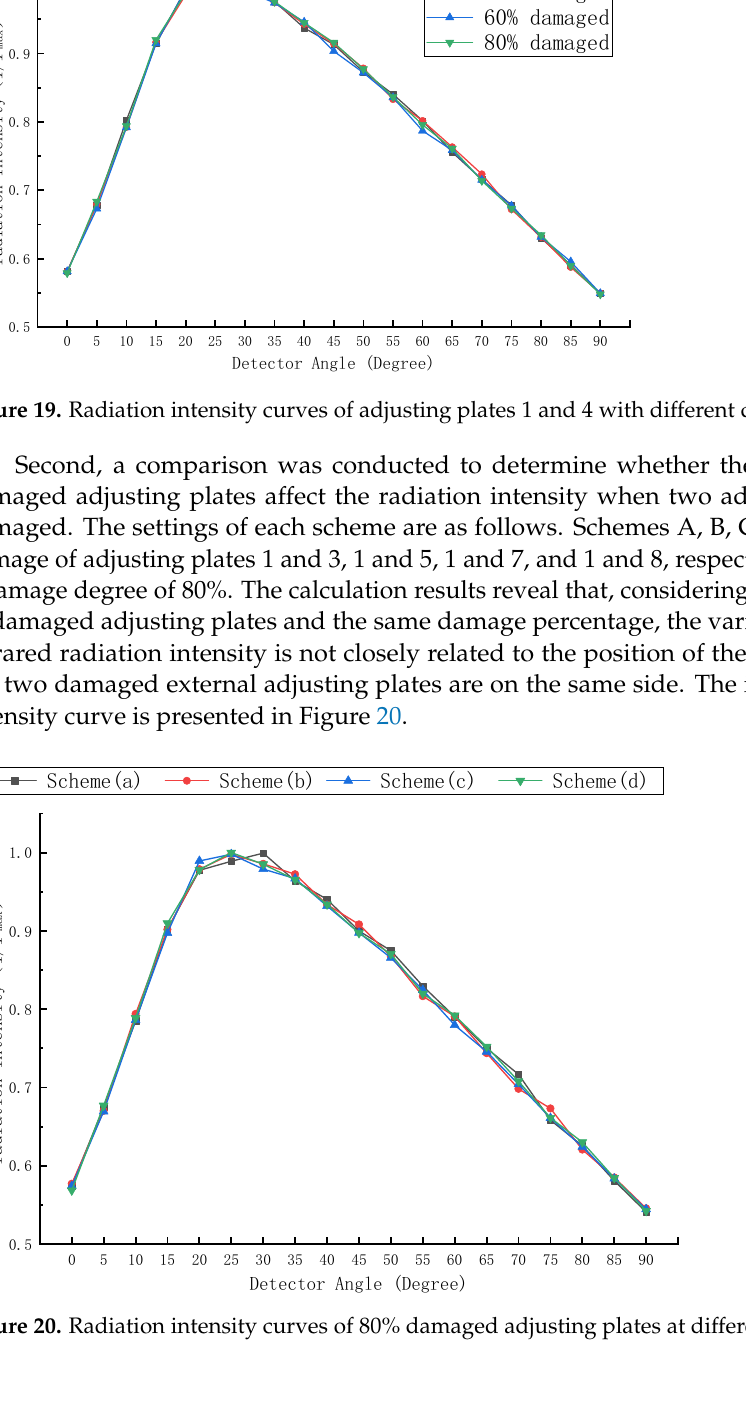
Figure 21. Comparison of radiation intensity with different numbers of damaged regulating plates. Based on previous research, it was learned that the damage of a single adjusting plate has little effect on the overall radiation intensity. Thus, the damage degree of all the ad- justing plates was set at 80%. As the number of damaged adjusting plates increases, the overall radiation intensifies and the integral radiation intensity reaches the peak value at the detection point of 25°, then gradually recedes with the increase in the detection angle.